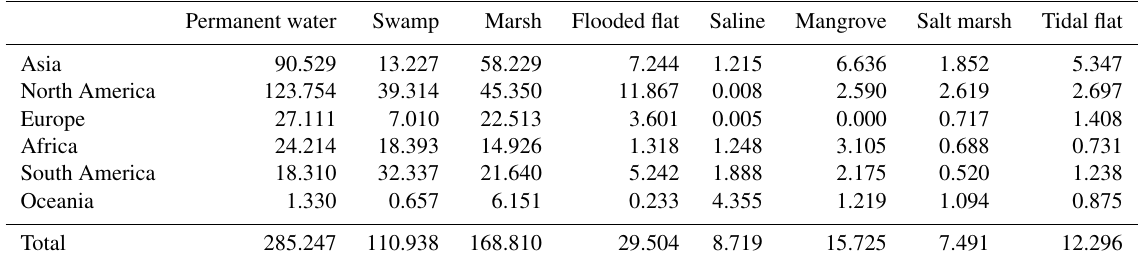
Table 4. The total wetland area (unit: 10 4 × km 2 ) of eight wetland sub-categories for six continents and the globe. Permanent water Swamp Marsh Flooded flat Saline Mangrove Salt marsh Tidal